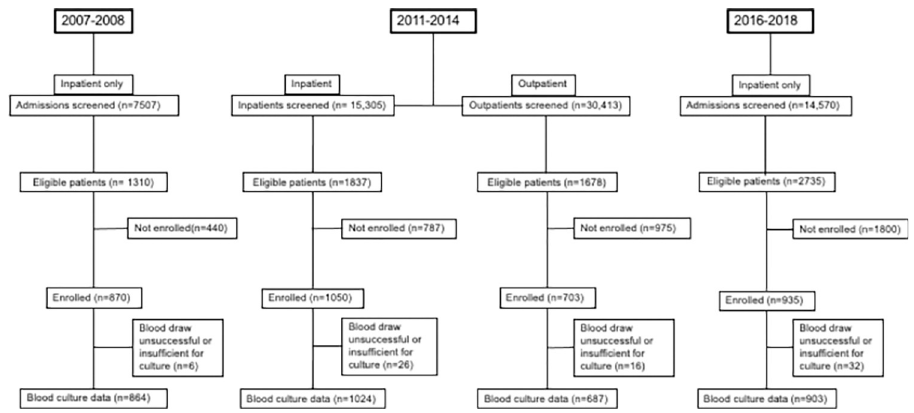
Fig 1. Screening and enrollment flow diagram for patients seeking care at Kilimanjaro Christian Medical Centre and Mawenzi Regional Referral Hospital in Moshi, Tanzania, 2007–2018.